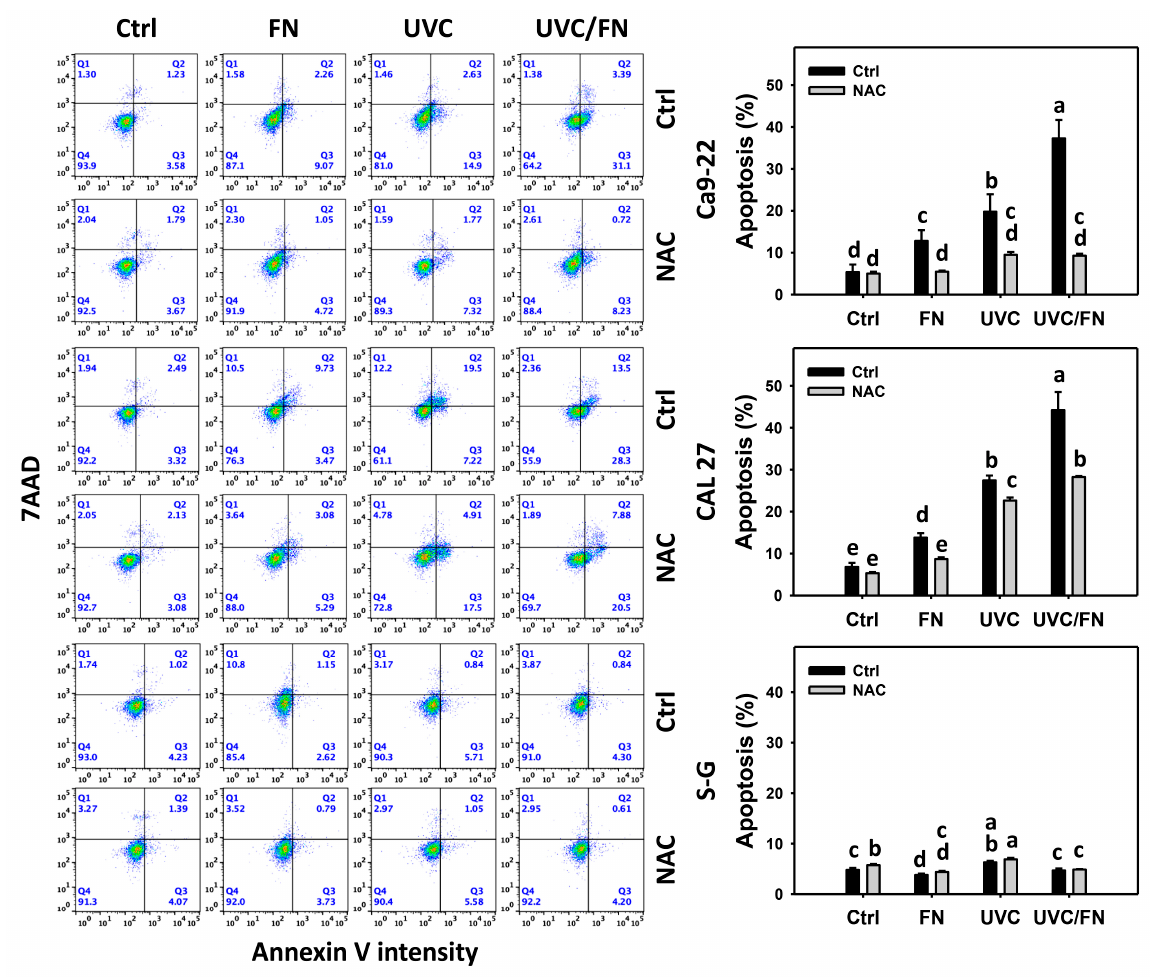
Figure 3. Annexin V/7AAD determination. There are four kinds of treatments for oral cancer (Ca9-22 and CAL 27) and non-malignant oral (S–G) cells: Control, FN (300 µ g/mL), UVC (10 J/m 2 for Ca9-22; 15 J/m 2 for CAL 27 and S–G), and UVC/FN (10 J/m 2 /300 µ g/mL for Ca9-22; 15 J/m 2 /300 µ g/mL for CAL 27 and S–G). NAC indicates that cells were pretreated with 10 mM NAC. Their intensity changes were evaluated by flow cytometry after a 24 h treatment. Annexin V (+)/7AAD ( − ) and (+) populations were defined as apoptosis (+). Data indicated as means ± SD ( n = 3). The low-case letters were assigned by JMP software to determine their significance. Significant differences are indicated by non-overlapping, lower-case letters ( p < 0.05).